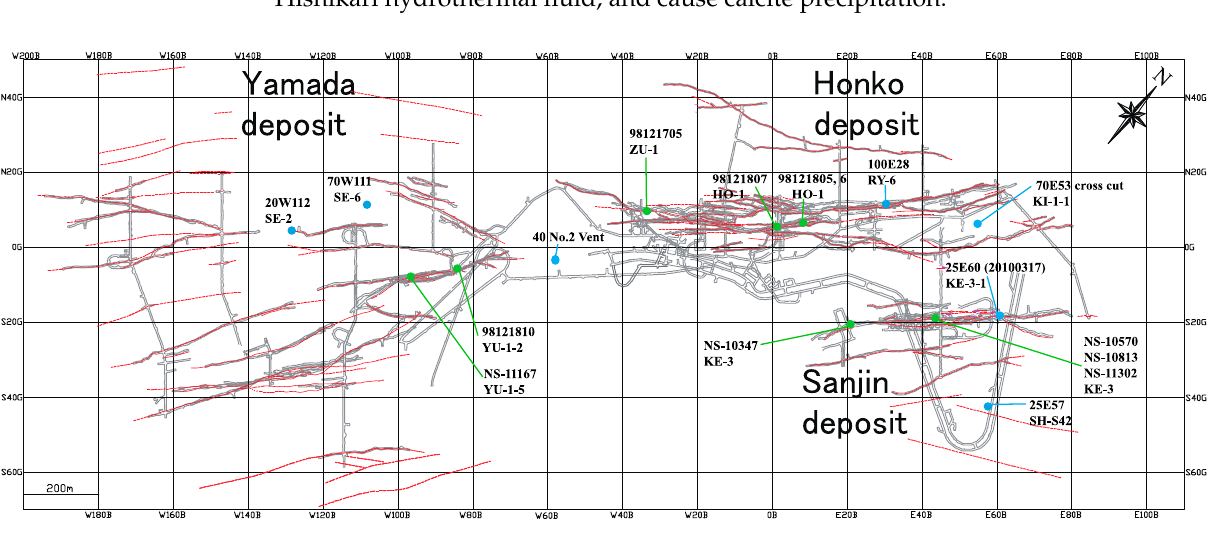
Figure 2. Sampling sites are shown on the vein system (red) of the Hishikari deposit. The number and vein name of the sample is attached next to the symbol. Blue symbols are for carbon and oxygen isotope ratios and green symbols are for sulfur isotope ratios.